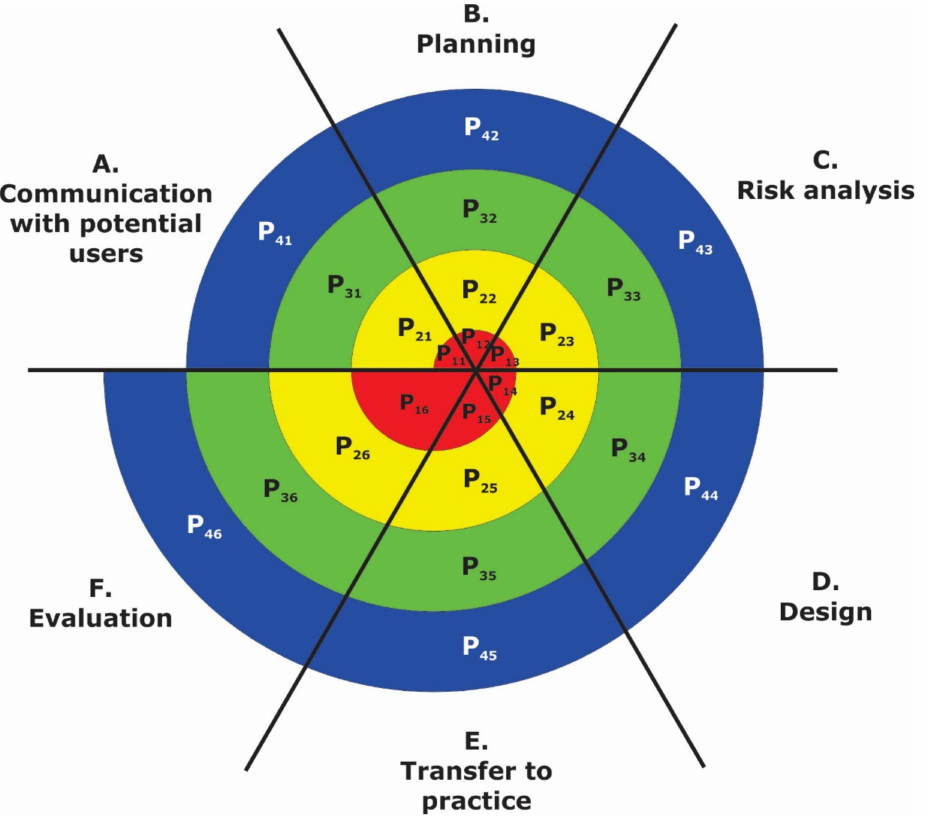
Figure 1. Matrix characteristic basic phase steps (P1 to P 6 in CBCPM renamed as ( A – F )), ( A )—communication with potential users (P 1 ), ( B )—planning (P 2 ), ( C )—risk analysis (P 3 ), ( D )—design (P 4 ), ( E )—transfer to practice (P 5 ), ( F )—evaluation (P 6